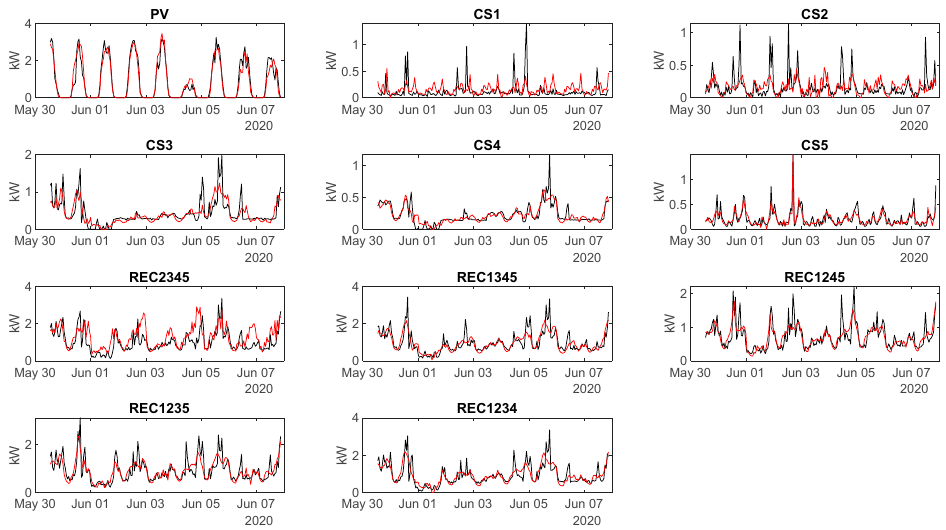
Figure 7. Extract of the enriched dataset showing forecasts for the PV produced power, the individual consumed power and the REC consumed power with different compositions.